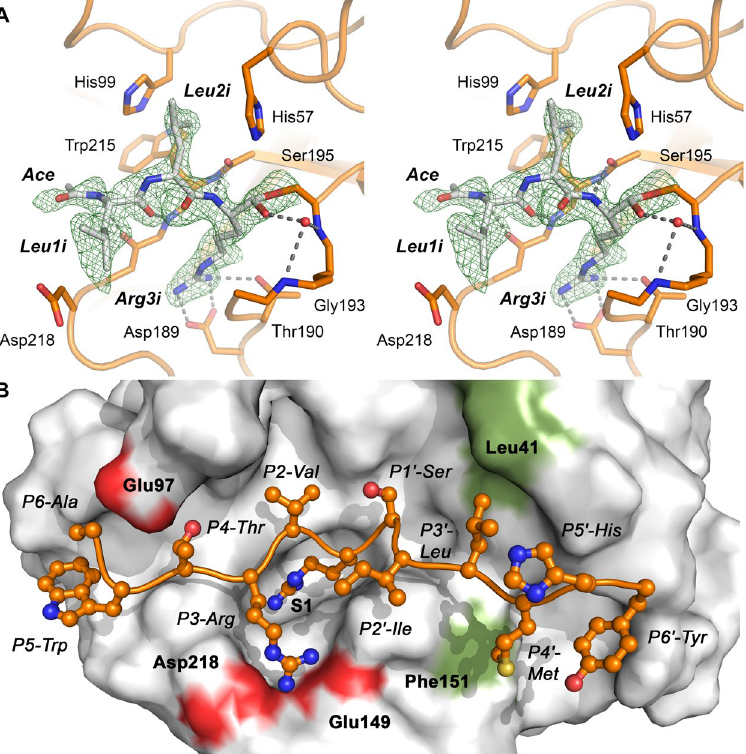
Figure 3. Leupeptin inhibitor and ideal substrate binding to the active site. ( A ) Stereo model of leupeptin in KLK8-leup, with the most relevant interacting residues displayed as sticks, e.g. the covalently linked Ser195. The electron density is a 2Fo-Fc map shown as green grid, contoured at 1.0 σ , hydrogen bonds are represented by grey dots. A water molecule (red sphere) occupies the oxyanion hole at the NH groups of Gly193 and Ser195 in this chain. ( B ) Molecular docking of an ideal substrate to KLK8 according to PICS profiling for residues P6